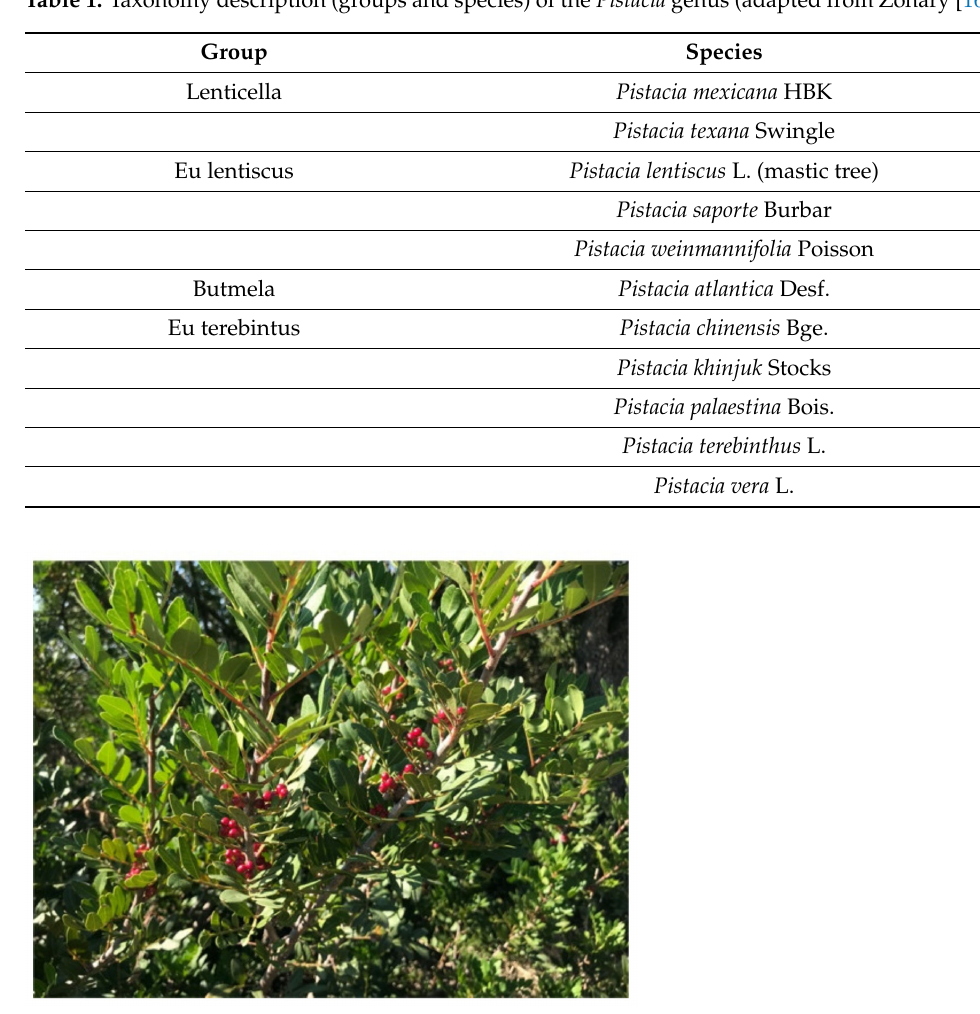
Figure 1. Pistacia lentiscus L., also known as mastic tree or